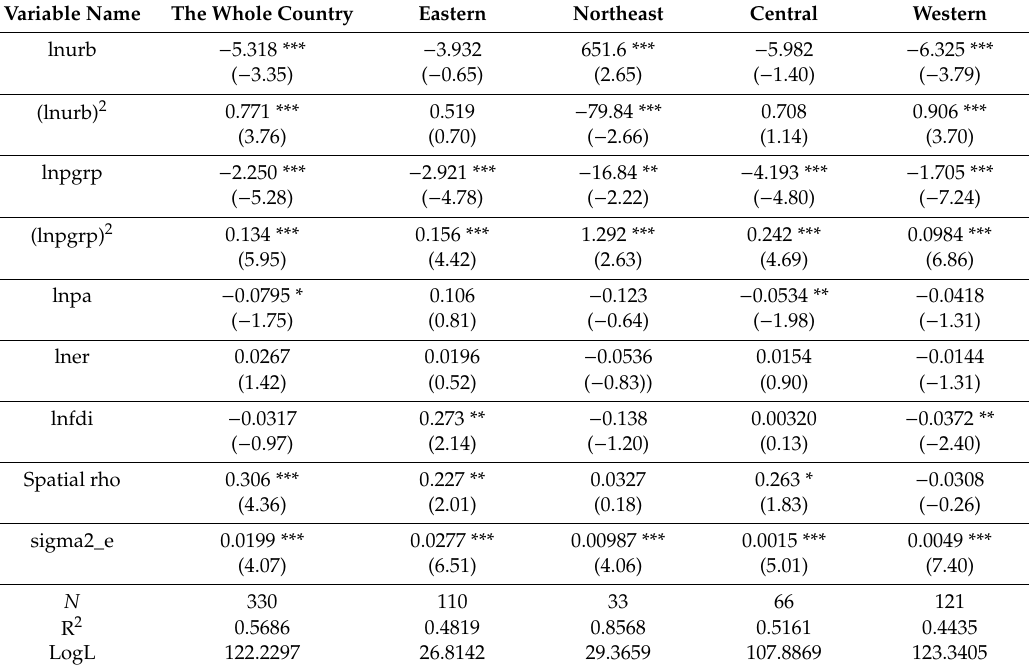
Table 5. Robustness